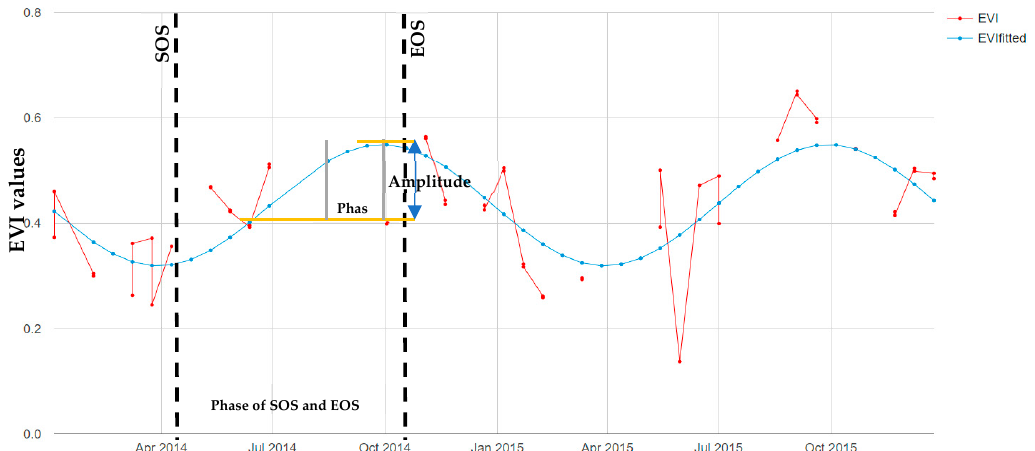
Figure 7. Example of a Landsat EVI time series of a deciduous forest showing the temporal profile of the harmonic regression model. The light blue dots/lines are the EVI fitted values and the red dots/lines show the original EVI values. The black dotted lines are the SOS and EOS estimates of the fitted EVI time series values. The amplitude of the deciduous forest is shown in the middle of the graph, and the phase represents the peak range of EVI pixel values at a given time. The phase of SOS and EOS represents the span of the growing cycle of deciduous forests in the region.